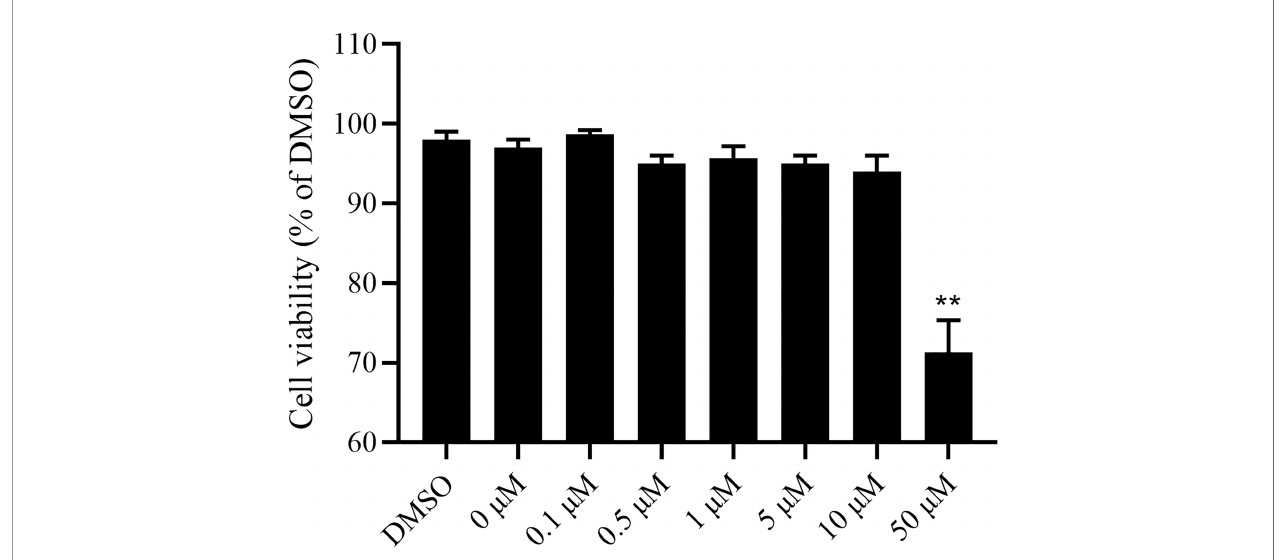
FIGURE 1 | Camptothecin cytotoxic effect on LMH cells. LMH cells were incubated with camptothecin at various doses ranging from 0 m M to 50 m M for 48 h. Then, CCK-8 assays were performed to examine the effect of camptothecin on the viability of LMH cells. All experiments were performed in triplicate ( n = 3). The error bars indicate the standard deviation of data from three independent experiments (** P <